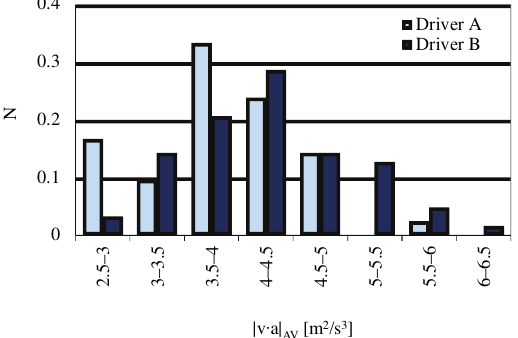
Fig. 21. Relative positive acceleration of the vehicle in extra-urban driving conditions